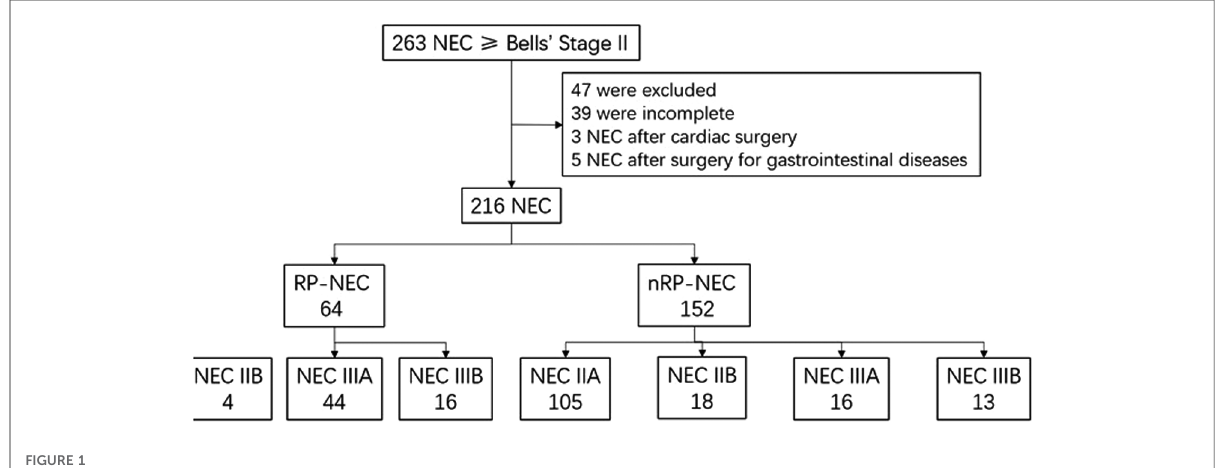
FIGURE 1 Flowchart for including